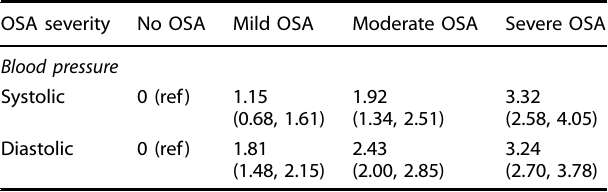
Table 2. β coef fi cients (mean and 95% con fi dence interval) of the association between obstructive sleep apnea (OSA) severity with diastolic and systolic blood